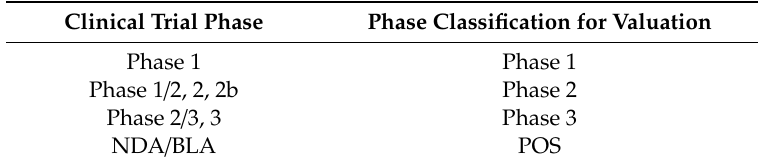
Table 4. Classification of the clinical